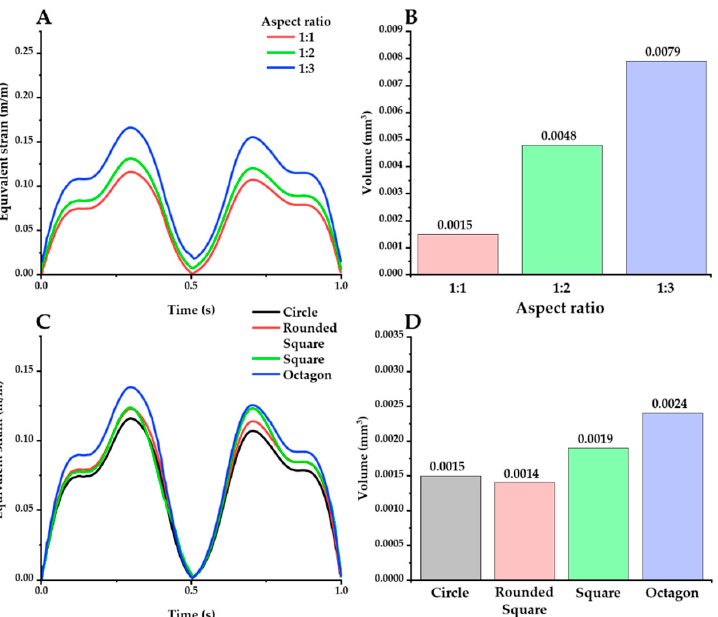
Figure 8. Equivalent strain distribution with varying aspect ratios ( A , B ) and shapes ( C , D ) (probe material: hydrogel). There are 2 kinds of plots for each factor: maximum equivalent strain versus time (A,C) and the volume of the critical region under different cross-section conditions ( B , D ).